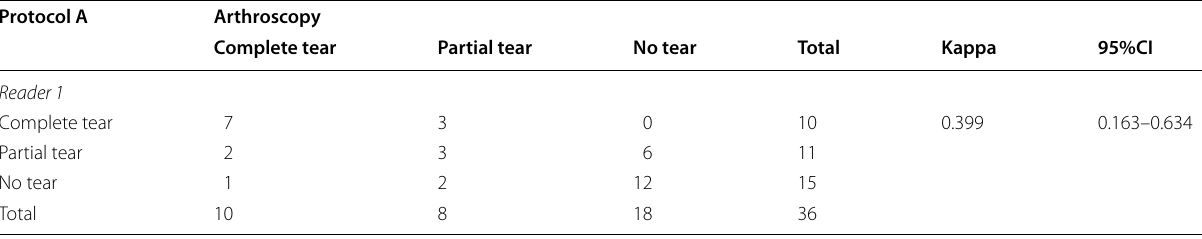
between MR grade and arthroscopic grade is also included